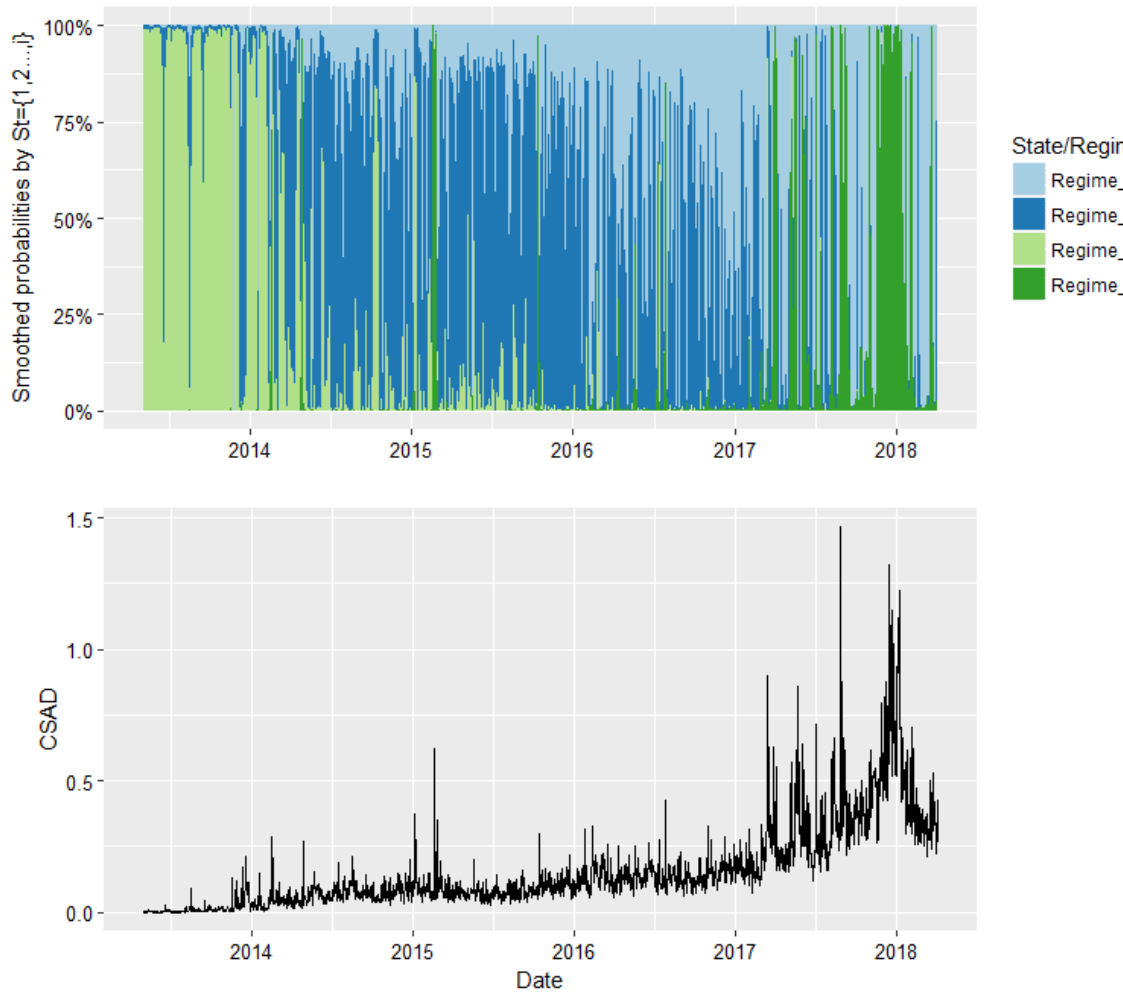
Figure 4: Regime switching smoothed probabilities under asymmetric herding behavior for the full